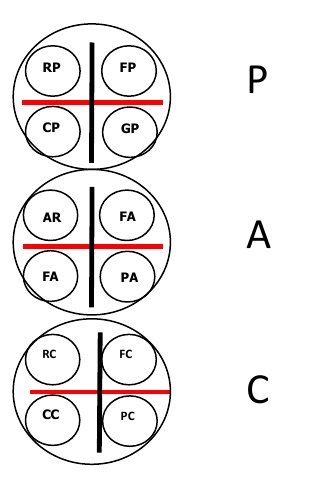
Figure 6: The three ego